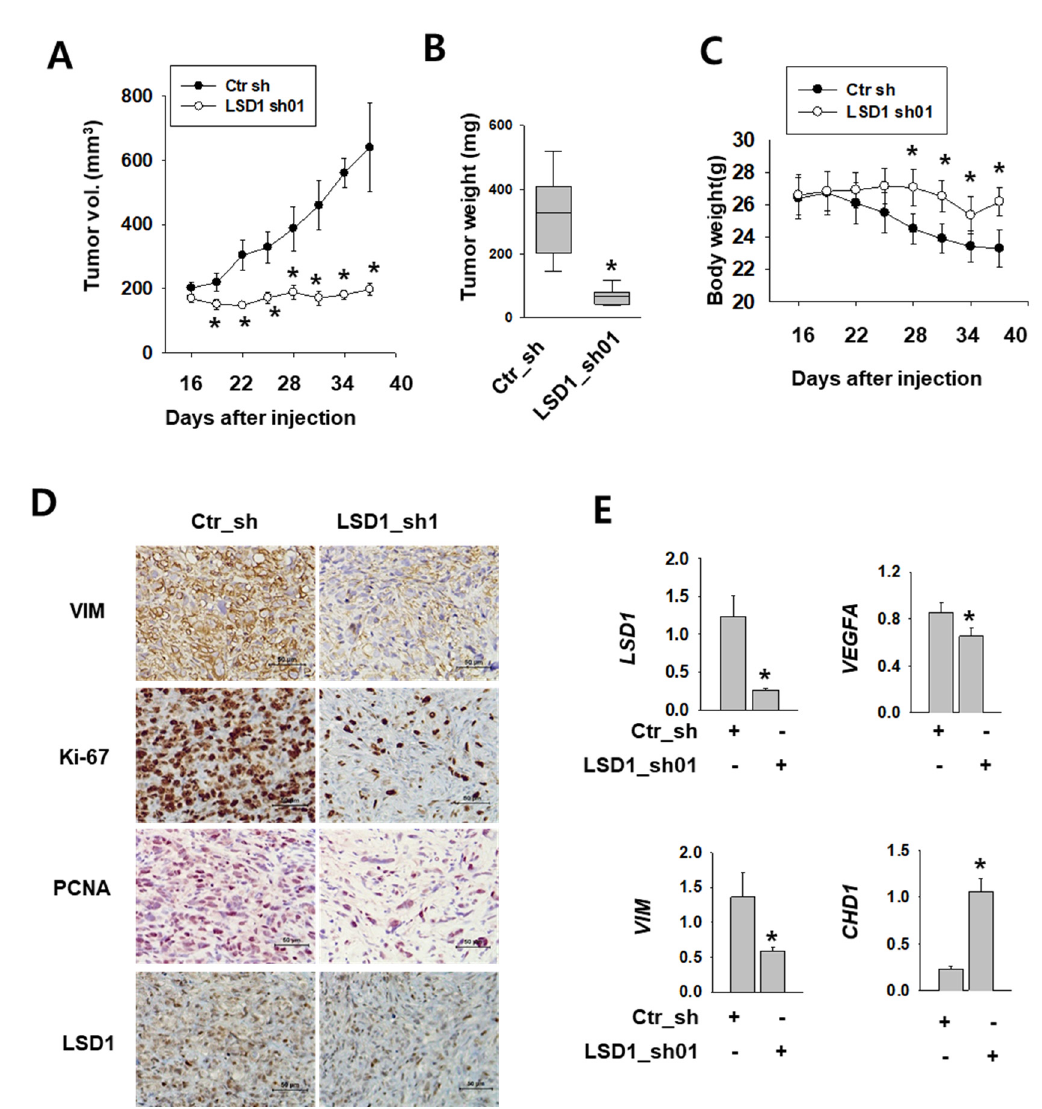
Figure 6. LSD1 repression attenuates tumor growth in human kidney cancer xenograft model. ( A ) Tumor size measured after injection of each indicated cell line into non-obese diabetic (NOD) severe combined immunodeficient (SCID) gamma (NSG) mice. Error bars represent the mean ± SEM ( n = 6) of each group. * denotes p < 0.05 (Student’s t -test) versus the ctr_sh group. ( B ) Relationship between tumor weights and LSD1 expression in the human kidney xenograft model. Tumors were excised and examined at the end of the experiments. Representative graph is shown as vertical box plots, and tumor weights are presented as mean (g) ± SEM ( n = 6). * denotes p < 0.05 (Student’s t -test) versus the ctr_sh group. ( C ) Mouse body weight was measured at indicated days after cancer cell injection. Error bars represent the mean ± SEM ( n = 6) of each group. * denotes p < 0.05 (Student’s t -test) versus the ctr_sh group. ( D ) Immunohistochemical images of indicated antibodies in para ffi n-embedded sections derived from the xenograft tumors. Scale bar, 50 µ m. ( E ) Quantitative PCR was performed for each gene using the mRNAs from each excised tumor. Error bars represent the mean ± SEM ( n = 6) of each group. * denotes p < 0.05 (Student’s t -test) versus the ctr_sh